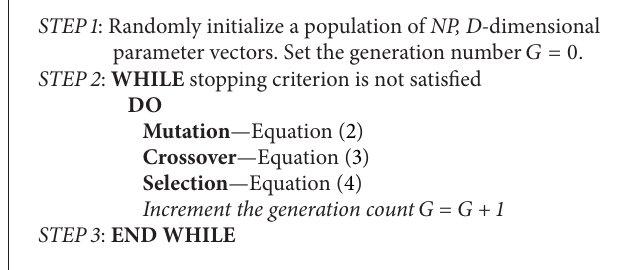
Algorithm 1: Standard differential evolution algorithm.